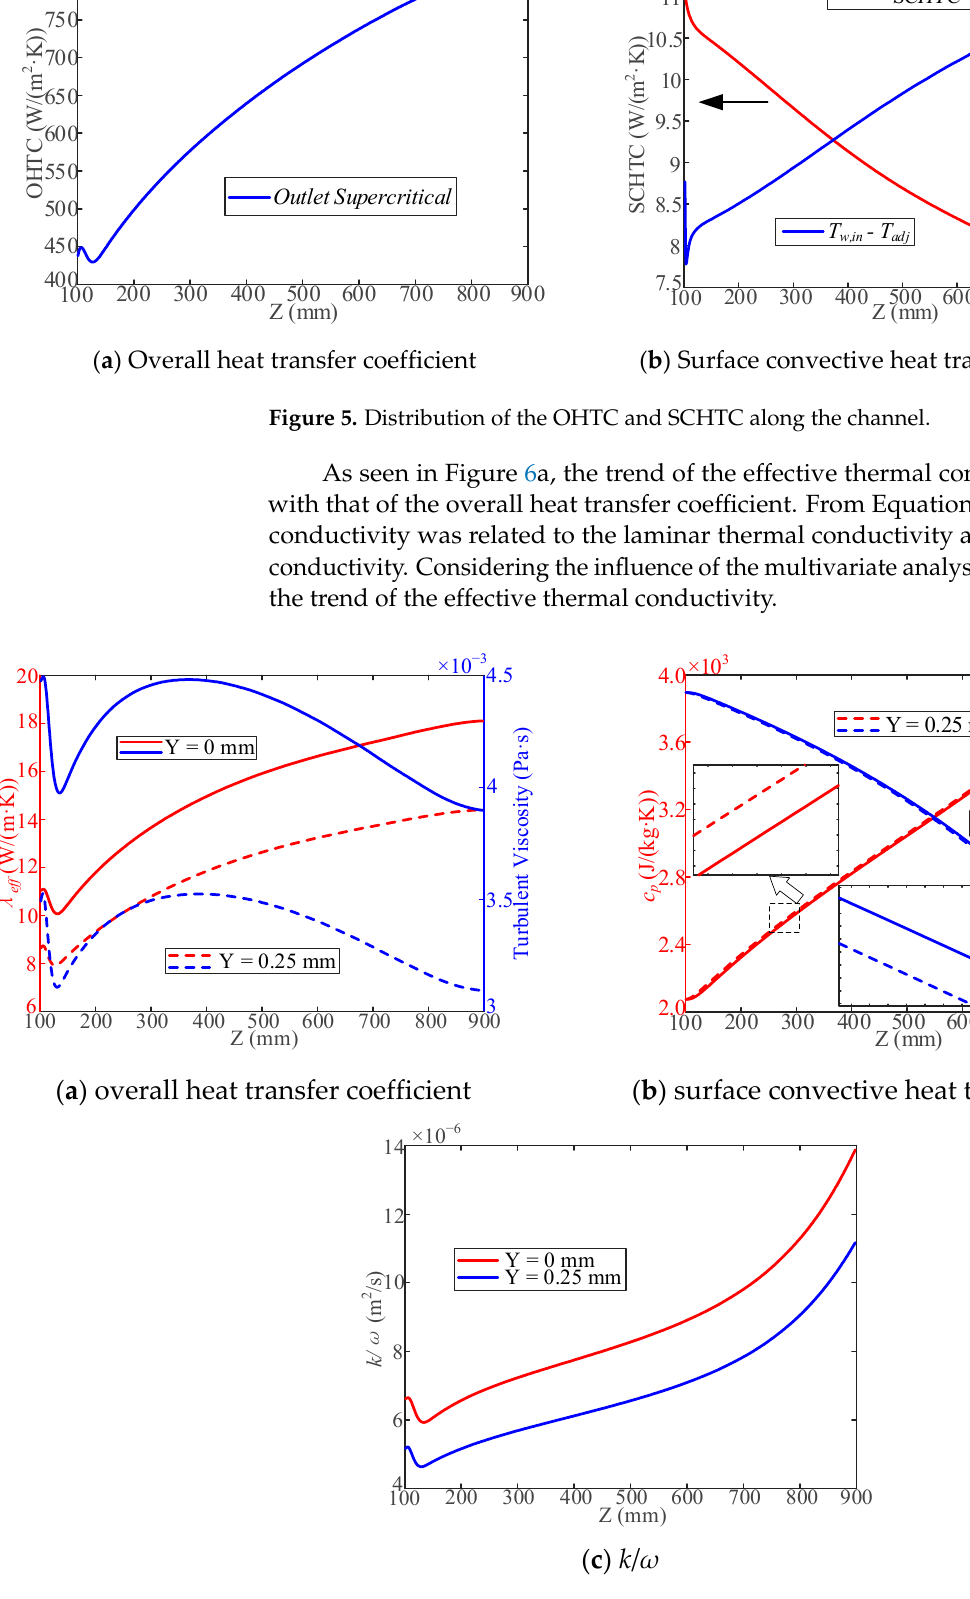
Figure 6. Distribution of λ eff , turbulent viscosity, c p , density, and k / ω along the channel.